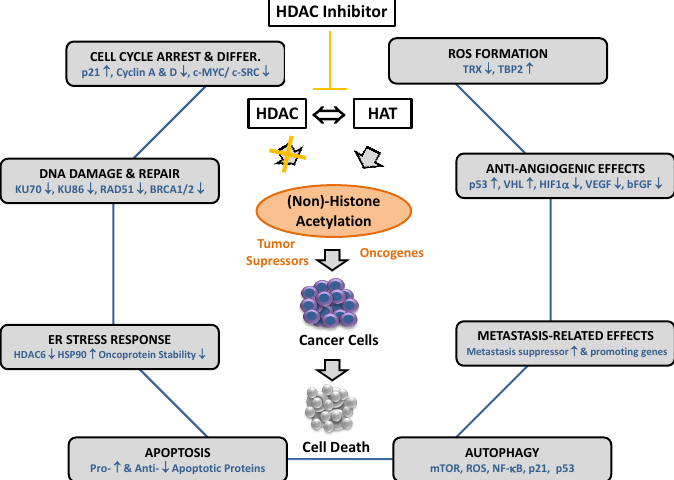
Figure 1. Overview about major e ff ector mechanisms of histone deacetylase (HDAC) inhibitor (HDACi) in cancer cells. Important individually a ff ected molecules (blue font) of the di ff erent categories of HDACi- activated anti-tumor pathways (grey boxes) are displayed. HDACi interfere with the deacetylation of histone and non-histone protein deacetylation of many tumor tuppressor genes and oncogenes (among other regulatory proteins) in cancer cells; this posttranslational modification renders them active and thereby induces the di ff erent e ff ector mechanisms eventually causing cell death. ↑ upregulation or activation; ↓ downregulation or inhibition; HAT, histone acetyl transferase(s); ROS, rewactive oxygen species; TRX, thioredoxin; TBP2, TRX-binding protein 2; p53, tumor suppressor protein p53; VHL, von Hippel Lindau factor; HIF1 α , hypoxia-inducible factor 1 α ; VEGF, vascular endothelial growth factor; bFGF, basic fibroblast growth factor; mTOR, mammalian target of rapamycin; NF- κ B, nuclear factor lappa B; p21, cyclin-dependent kinase inhibitor 1 (p21 CIP / WAF1 ); HDAC6, histon deacetylase 6, c-MYC , cellular homolog of the oncogene ( v-myc ) of avian myelocytomatosis virus strain 29; c-SRC , cellular SRC kinase oncogene; ER, endoplasmatic reticulum; Ku70, Lupus Ku autoantigen protein p70; Ku 86, Lupus Ku autoantigen protein p86; RAD51 (BRCC5); DNA repair protein RAD51 homolog; BRCA1 / 2, BRCA1 / 2, DNA repair associated (prev. breast cancer suceptibility protein 1